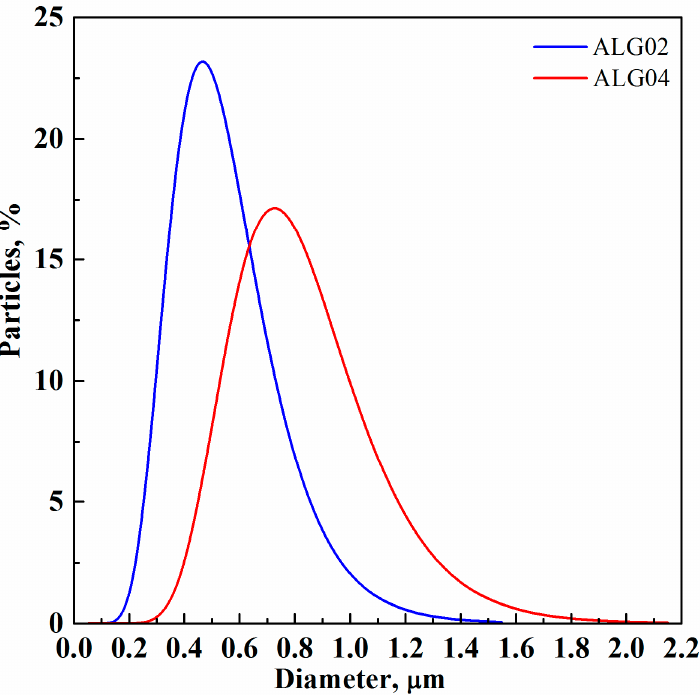
Figure 5. PSDs of sodium alginate microparticles and sodium alginate plus salicylic acid microparticles, produced via SAA at 80 °C, 82 bar, and GLR = 1.8. Sodium alginate and salicylic acid untreated powders, sodium alginate and salicylic acid untreated powders mixed in a 1/4 weight ratio (physical mixture), and the loaded